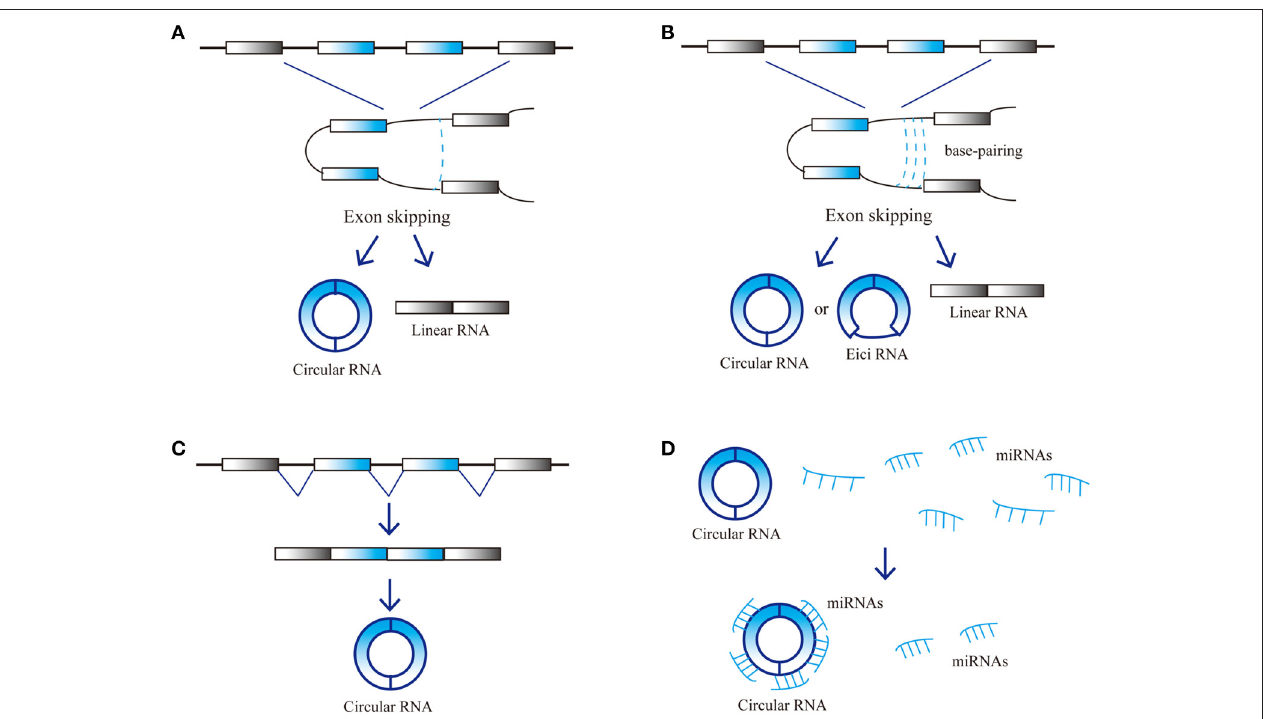
FIGURE 1 | Possible models and function of circRNA biogenesis. (A) Lariat-driven circularization, (B) Intron-pairing-driven circularization, (C) Resplicing-driven circularization, and (D) Function as miRNAs